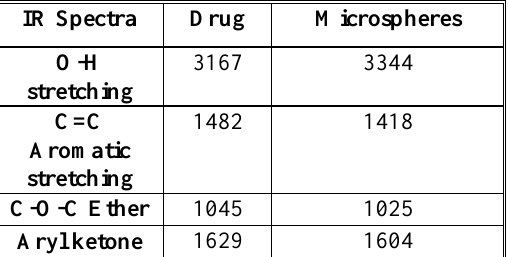
Figure 1. Standard curve of Acyclovir in 0.1 N HCl at λ max 252 nm